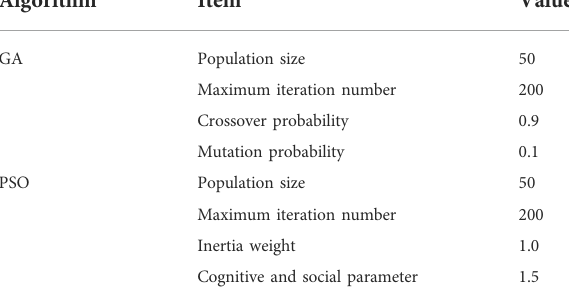
TABLE 4 GA and PSO